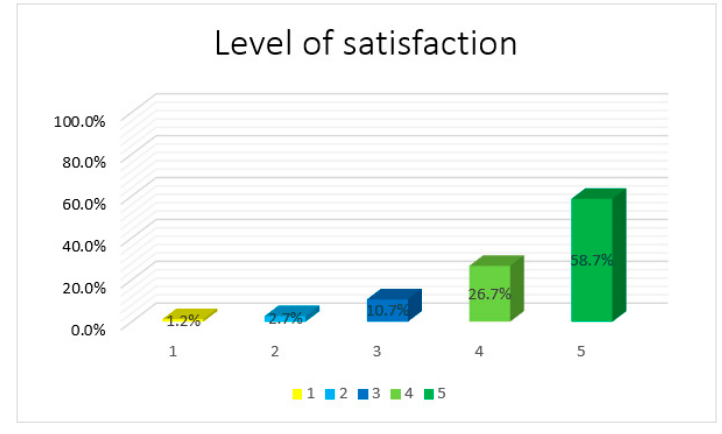
Figure 20. Percentage of satisfaction level in regard to previous VR experience.